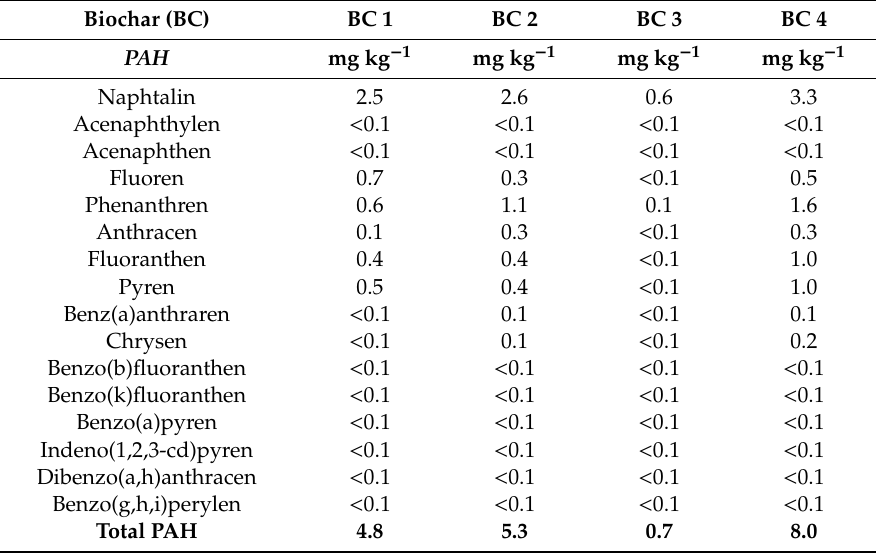
Table 4. Values for the polycyclic aromatic hydrocarbons (PAHs) in four BCs 2